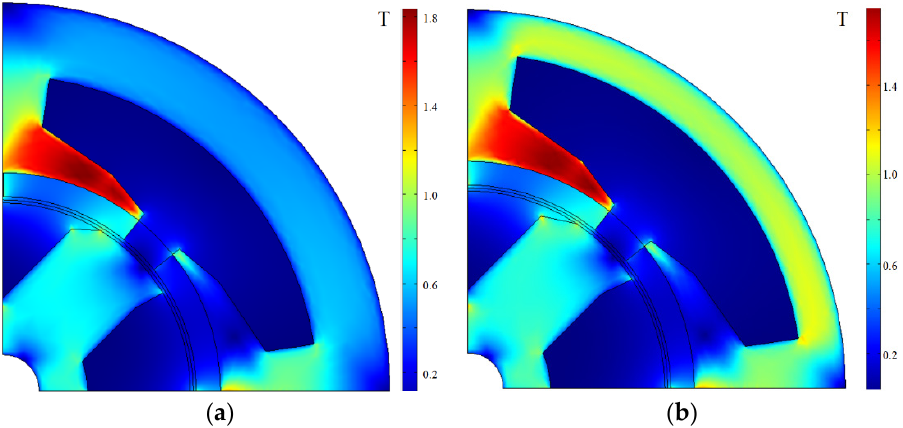
Figure 2. Calculation area arrangement and flux density magnitude plot (T) in the FRM ( a ) before optimization and ( b ) after.